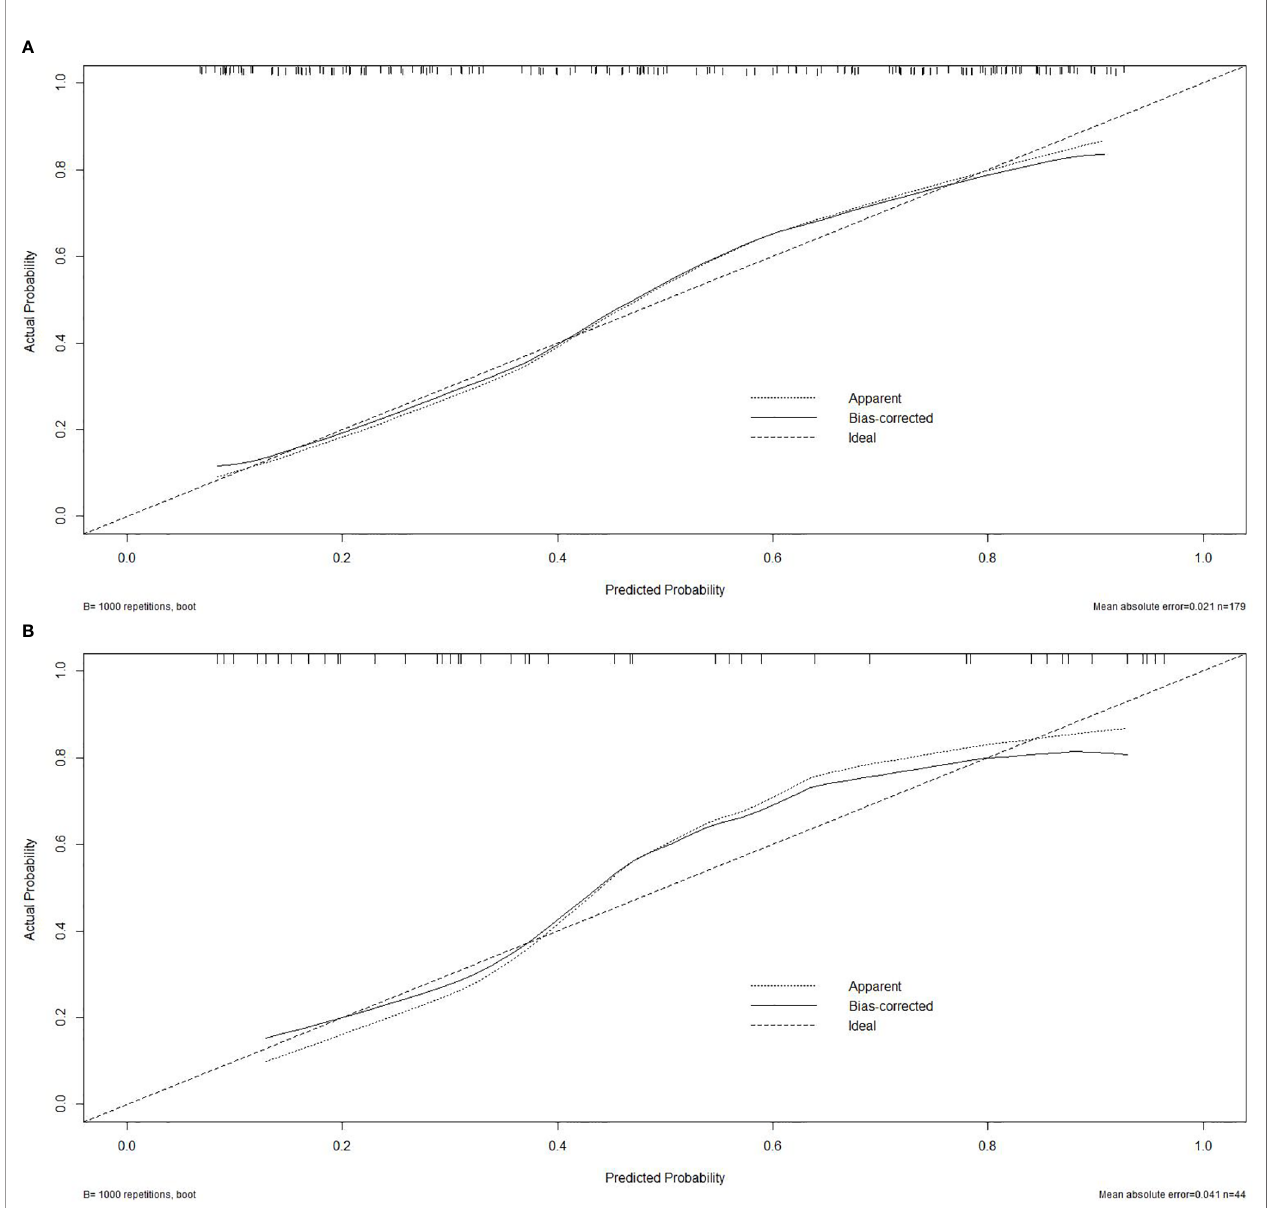
FIGURE 4 | Calibration curve. (A) Calibration curve of the nomogram in the training cohort. (B) Calibration curve in the validation